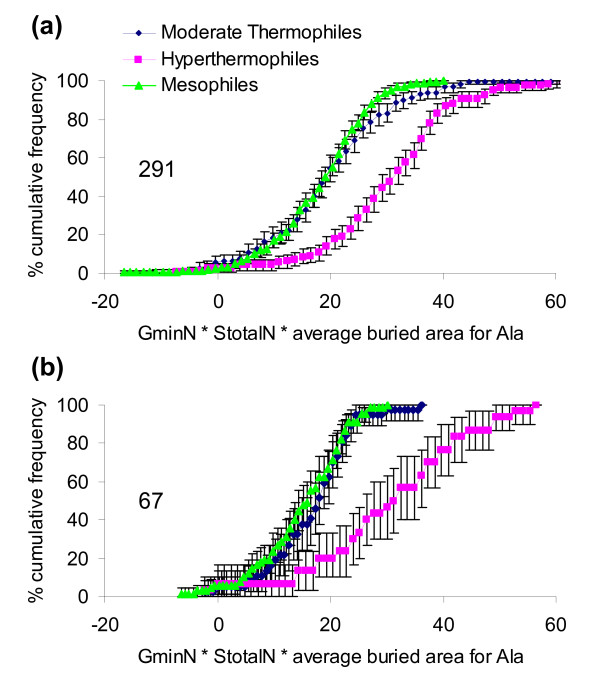
Separation of proteins by three properties. The triple product GminN * StotalN * (the average buried area per alanine residue) is used for (a) 291 set and (b) the 67 set. Error bars are derived from the 5 and 95 percentile levels by bootstrap resampling.